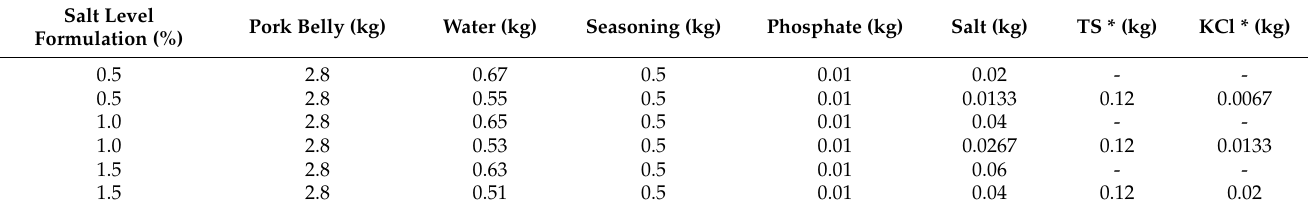
Table 1. Formulation for breakfast sausages (4.0 kg) manufactured using HP-treated pork belly meat at 150 MPa for 5 min with varying salt levels and 0.25%